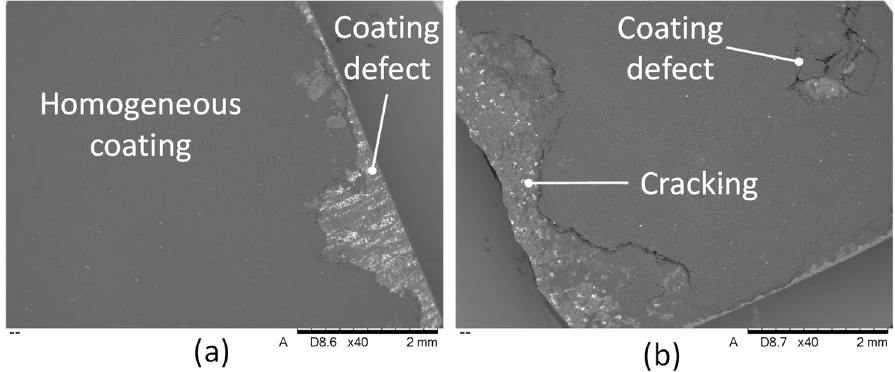
Figure 4. SEM images detailing the edge of the sample of Test A: ( a ) undeposited coating, ( b ) coating cracking.